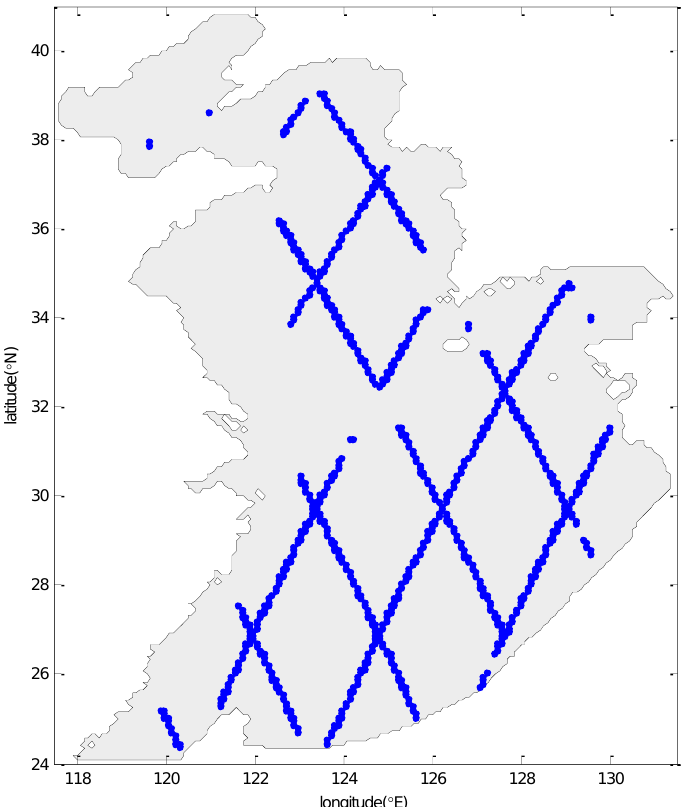
Figure 2. Blue dots mean the locations of TOPEX/Poseidon observation points.